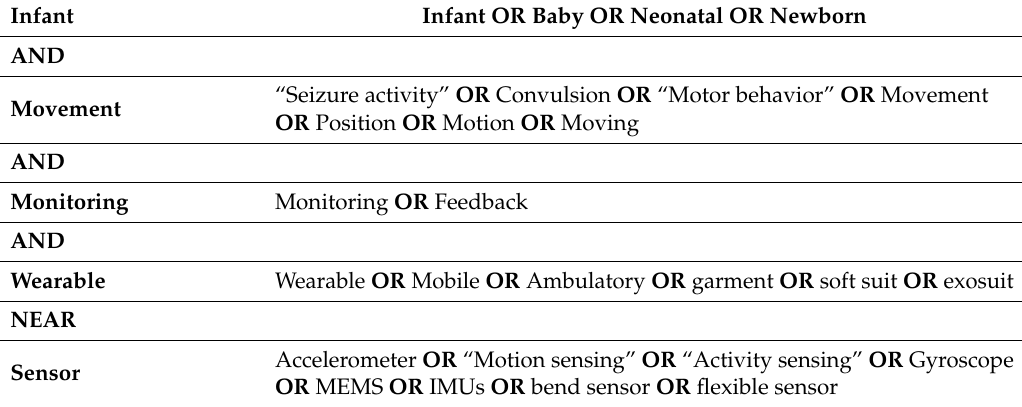
Table 1. Literature search strategy